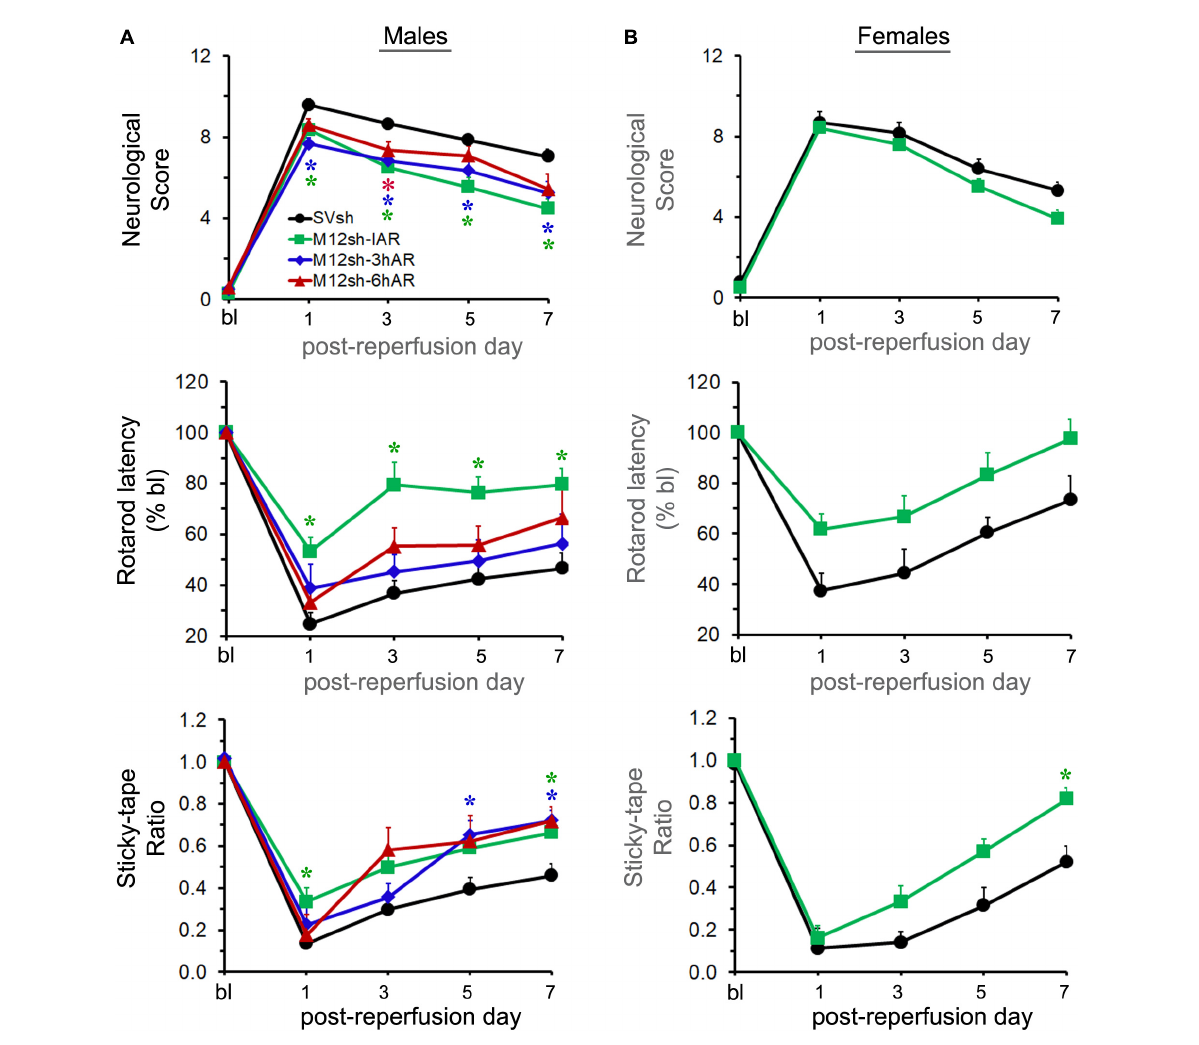
FIGURE3 The effect of a single-dose M12sh treatment given at different times after reperfusion on post-stroke neurological and functional recovery. Following 2-h focal cerebral ischemia, both male (A) and female (B) rats subjected to treatments with either SVsh (immediately after reperfusion) or M12sh (immediately after reperfusion, 3-h after reperfusion, or 6-h after reperfusion) were evaluated for assessment of various neurological and functional tests at baseline (bl) and at regular intervals (days 1, 3, 5, and 7). Post-ischemic neurological and functional deficits were assessed by the mNSS assessment, the accelerating Rotarod performance, and the modified adhesive removal tests. n = 23–28 males and 11–13 females (SVsh group), 26–28 males and 20–22 females (M12sh-IAR group), 10-12 males (M12sh-3hAR group), and 12 males (M12sh-6hAR group) for the various tests. Statistical analysis: Two-way repeated-measures ANOVA followed by Dunnett’s/Sidak’s multiple comparisons tests. * p < 0.05 vs. SVsh (respective post-reperfusion